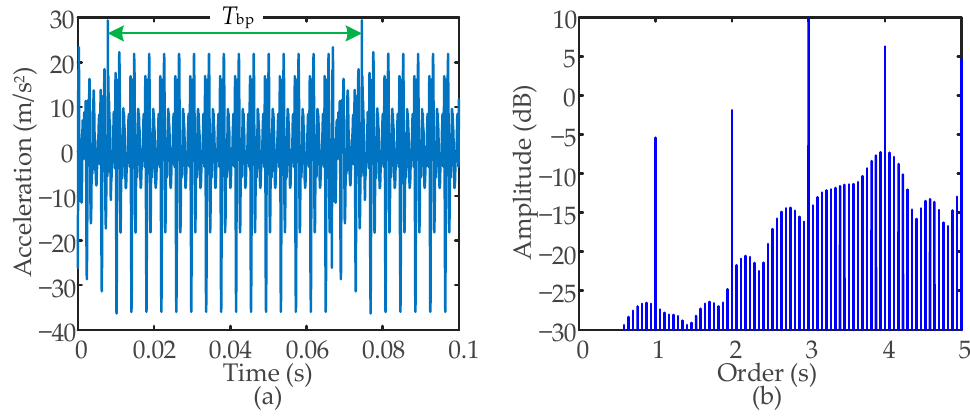
Figure 19. Case 4: ( a ) Time-domain waveform; ( b ) Amplitude spectrum.